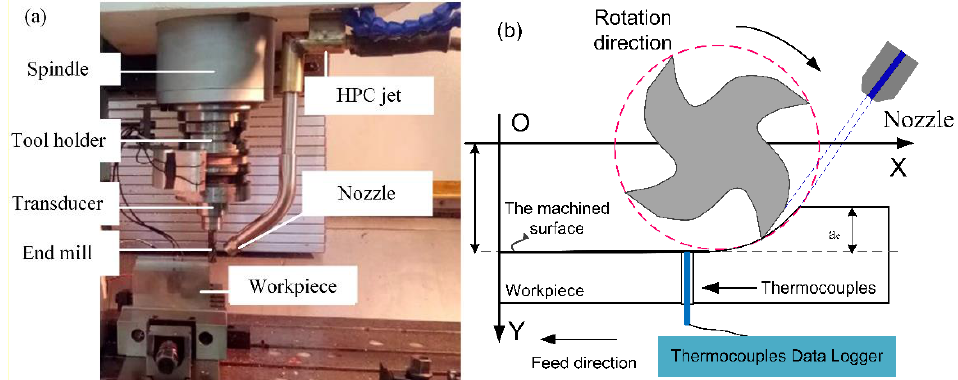
Figure 7. ( a ) Platform of HRUEM with HPC and ( b ) schematic diagram of the temperature Figure7. ( a )PlatformofHRUEMwithHPCand( b )schematicdiagramofthetemperaturemeasurement. measurement. Table 2. Conditions of the end